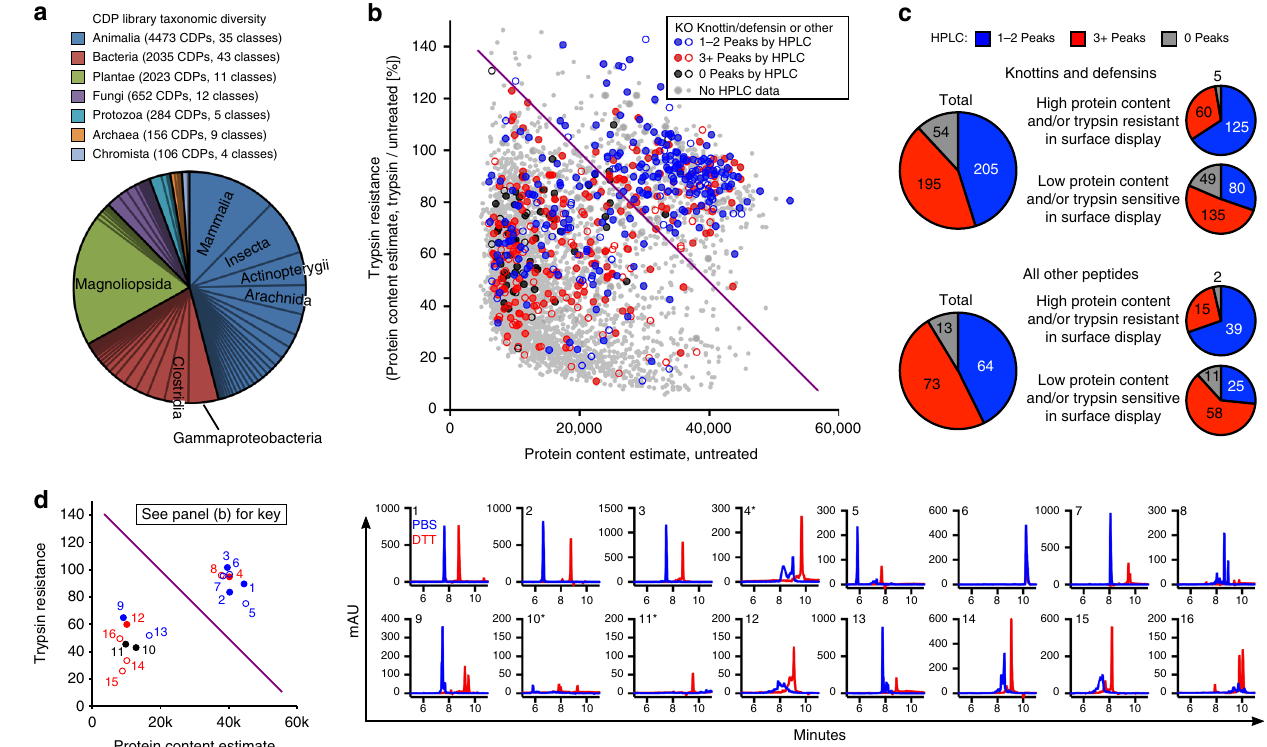
Fig. 2 Cell surface folding of displayed cystine-dense peptides correlates with proper folding as soluble peptides. a Taxonomic diversity of the library. Classes with > 300 library members are named. 270 peptides had missing or corrupt taxonomic lineages. b Of 9999 CDPs cloned into SDGF and transduced as a pool, 4298 passed read abundance thresholds and were quantitated for surface protein content in untreated cells ( X axis) and trypsin- treated cells ( Y axis, as a percentage of untreated surface protein content to measure trypsin resistance). The diagonal line de fi nes an arbitrary cutoff between “ High protein content and/or trypsin resistant ” (HC/TR) and “ Low protein content and/or trypsin sensitive ” (LC/TS). Symbols were assigned by HPLC validation performance (1-2 Peaks, blue; 3+ Peaks, red; 0 Peaks, black; or no HPLC data, gray) and by “ Knottin/Defensin ” ( fi lled) or “ Other ” (empty, or small gray) classi fi cation. Values represent the average of two independent replicates of the complete experiment. c Secreted protein HPLC performance, as categorized by peptide classi fi cation and by protein content / trypsin resistance. For both peptide categories, the correlation between surface folding (HC/TR vs LC/TS) and HPLC performance (1-2 Peaks vs 3+ or 0 Peaks) was highly signi fi cant ( P < 1 × 10 − 6 by concordance of surface and soluble folding properties before vs. after HPLC classi fi er shuf fl ing). d HPLC traces of 16 representative peptides under native (PBS, blue) or reducing (DTT, red) conditions. Peptides 4, 10, and 11 contain potential glycosites (NXS/T) and are marked with an asterisk. Plot on the left is same as in b , with only the 16 representative peptides displayed, matched by number to the HPLC plots. Full protein information for the 16 representative peptides is found in Supplementary Table 2. See Supplementary Fig. 2, the Methods, and the Supplementary Methods for detailed illustrations and protocols for high throughput surface protein content